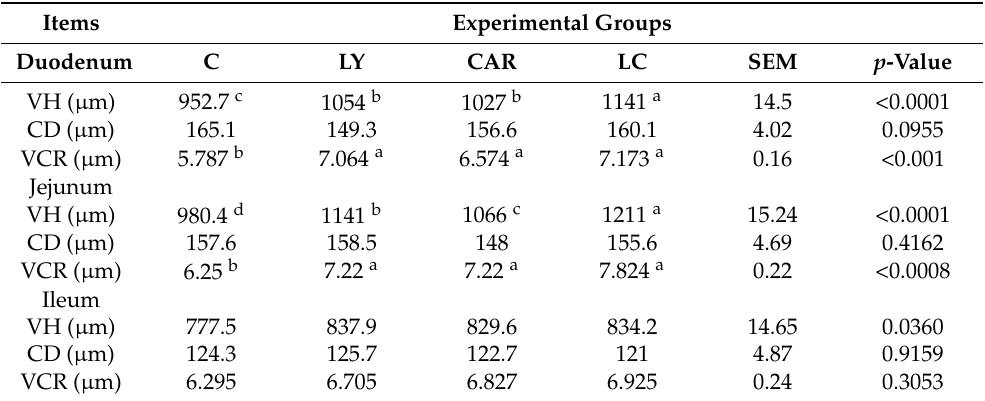
Table 3. Effects of Lycopene and L-Carnitine supplementation with/without combination on intesti- nal morphology of